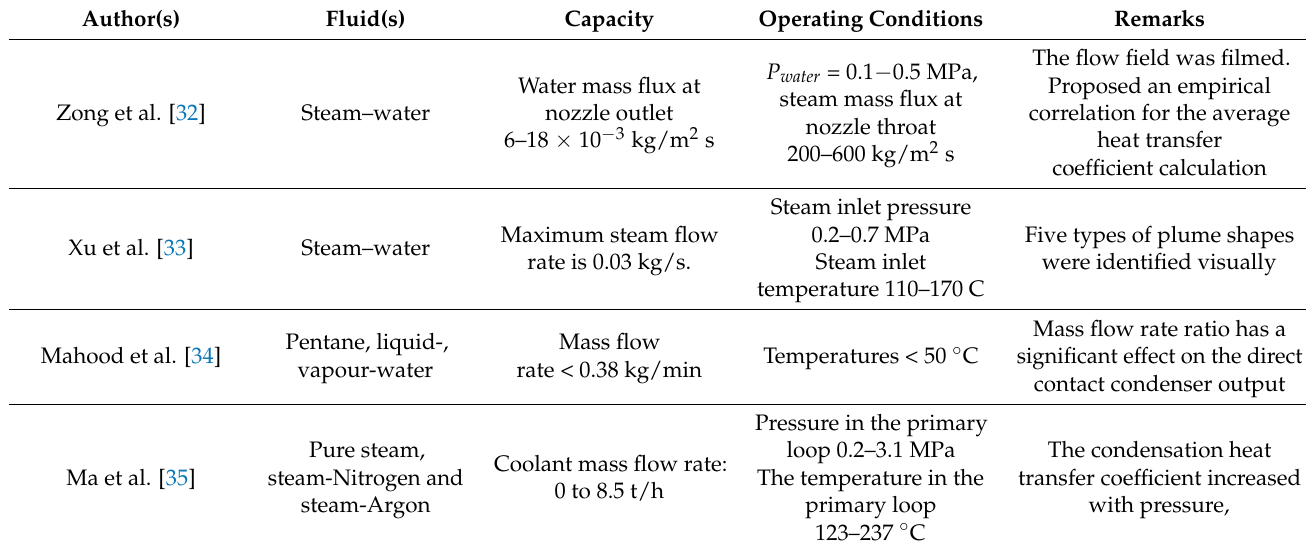
Table 1. Main areas investigated in experimental studies on direct contact condensers.